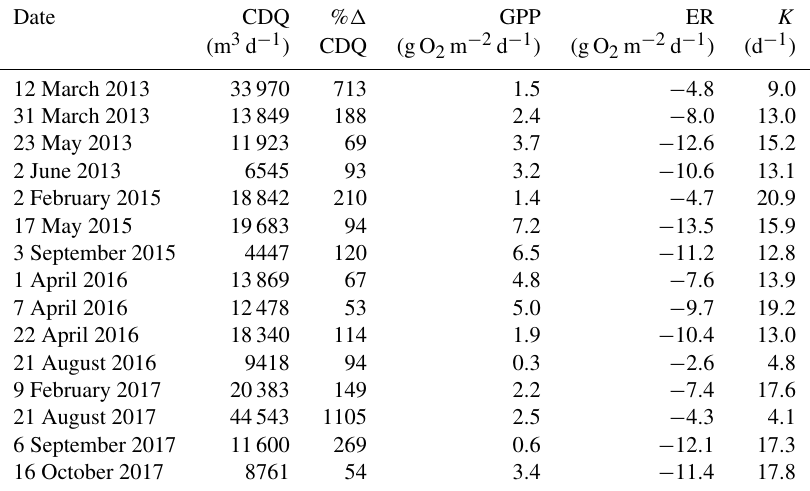
Table 2. Cumulative daily discharge (CDQ), percent change in CDQ relative to the prior day, metabolism (gross primary production (GPP), ecosystem respiration (ER)), and air–water gas exchange ( K ) of isolated flow events analyzed for metabolic recovery.